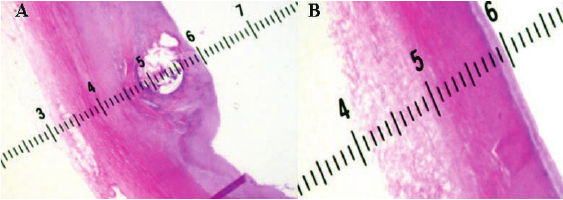
Fig. 7 - A. Corte histológico longitudinal de aorta do suíno no 7 no local onde fora colocado um stent mostrando a medida micrométrica do espessamento da parede de 3,0 milímetros (10 X HE). B. Corte histológico de aorta do suíno no 7 no local sem stent mostrando a medida micrométrica do espessamento da parede de 1,9 mm (10X HE).